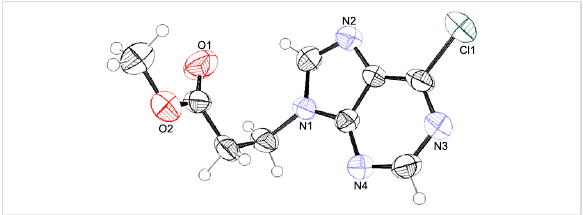
Figure 2: X-ray structure of 1ea shown as thermal ellipsoids at 50% probability [17,18].